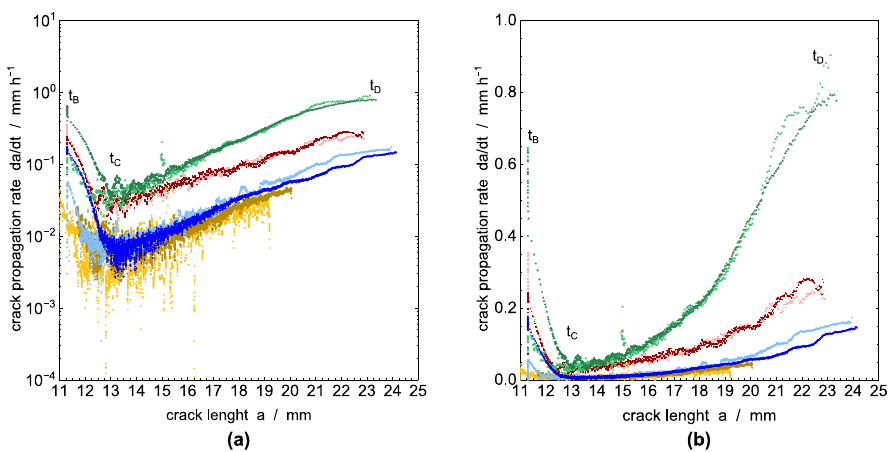
Figure 7. Crack propagation rate in ( a ) semi-logarithmic and ( b ) linear scale plots of static loaded CT specimens as a function of local crack length for different environmental media at 40 °C media temperature. PFL-FR 2323 (yellow), PFL-FR 2344 (green), distilled water (blue), 2 wt% aq. Arkopal N100 (red).